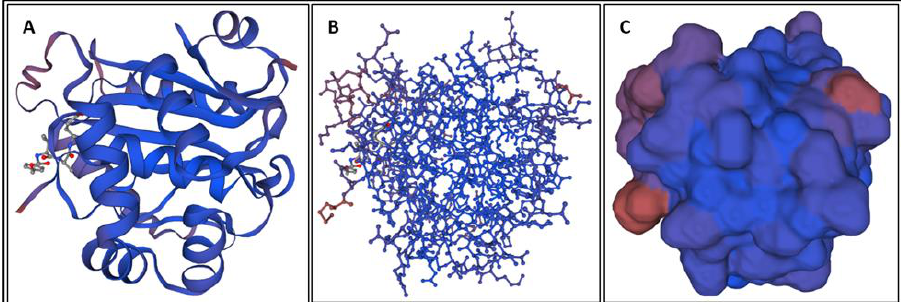
Figure 2. ( A ) A cartoon model, ( B ) a ball-and-stick model, and ( C ) a surface model of GFAP [24].